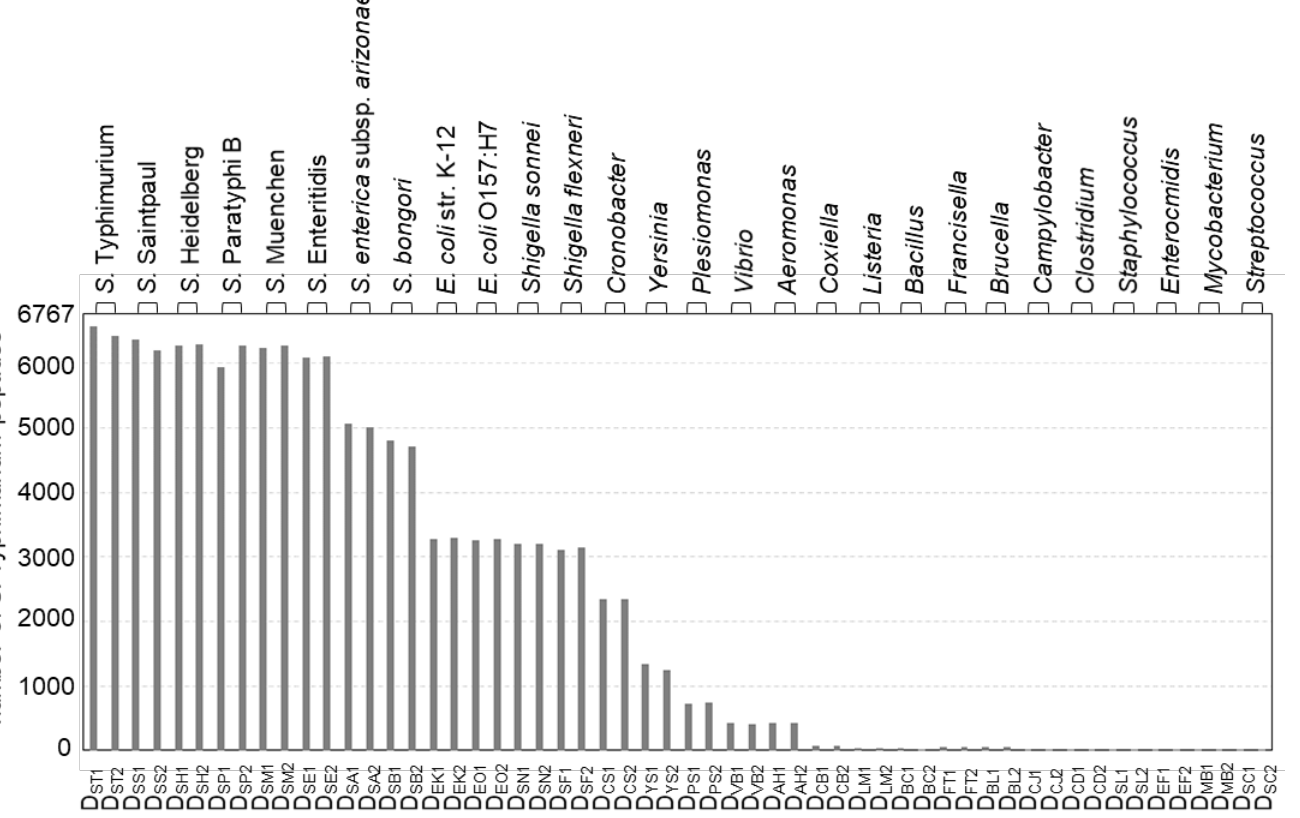
Figure 3. The number of peptides identified in the S. Typhimurium SARA2 isolate present in each reference proteome. See Table S1 for the detailed reference proteome information.